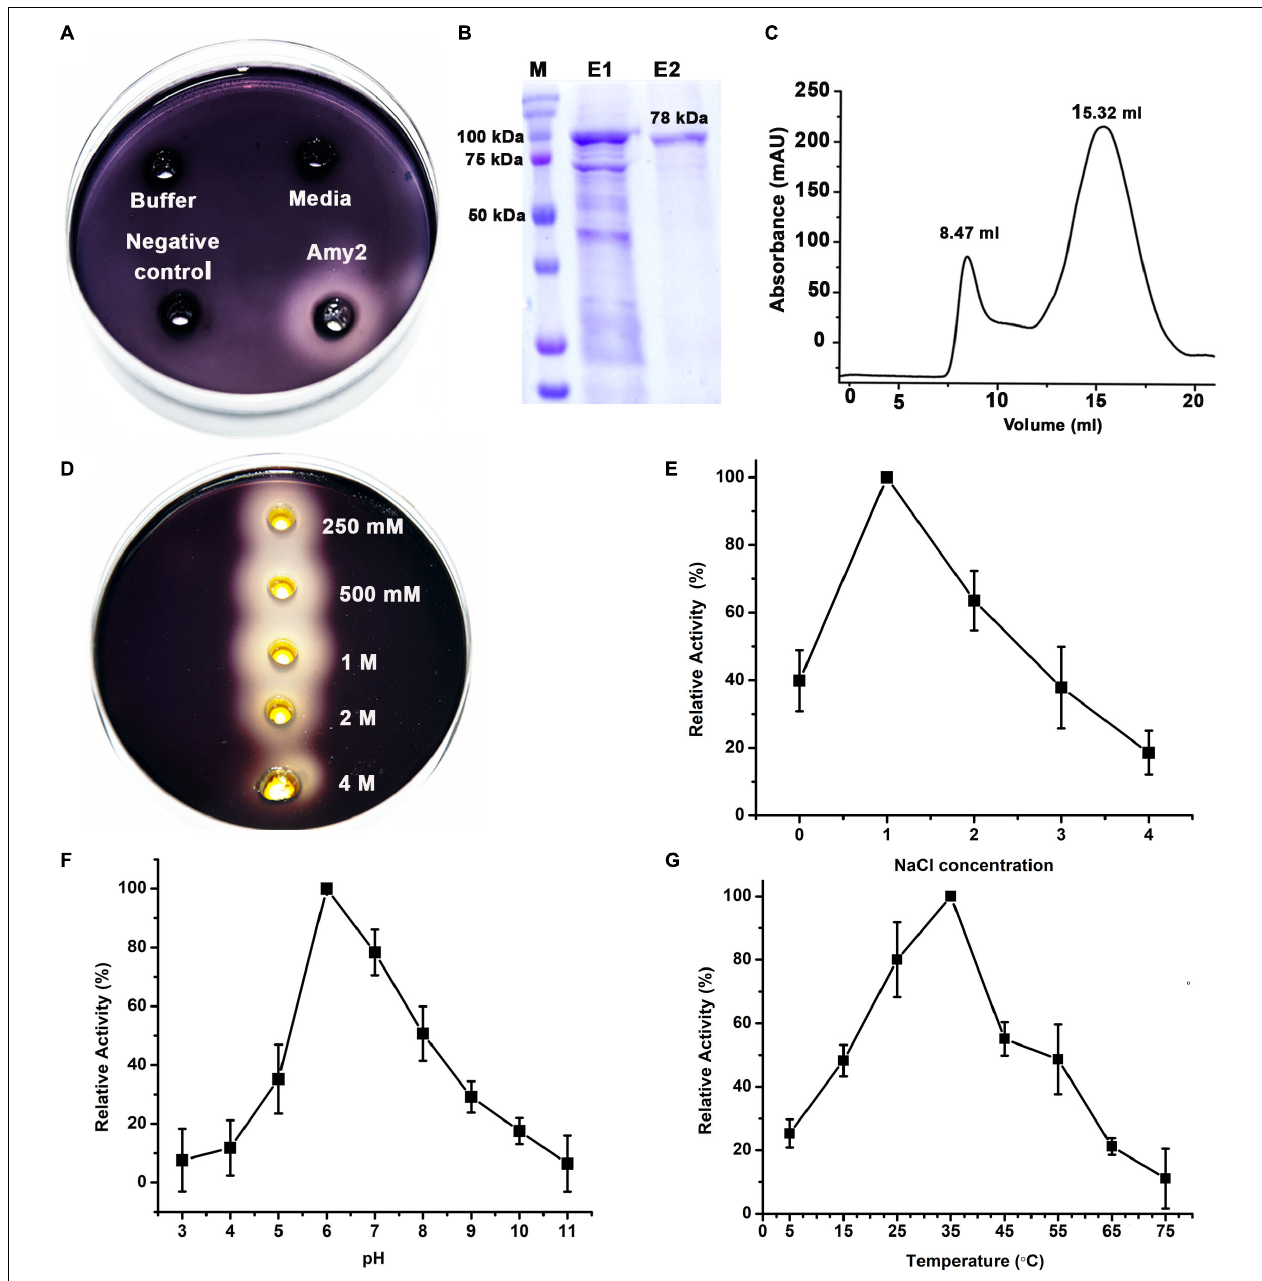
FIGURE 4 | The purification of recombinant α -amylase from E. coli , and carotenoids from wild type cultures. (A) The α -amylase activity observed from the cell-free supernatant of E. coli expressing recombinant Amy2. (B) The 15 % SDS-PAGE showing a predominant protein band at the expected molecular weight of ∼ 78 kDa in the gradient of imidazole elution fractions (E1, E2, E3 correspond to 20, 100, and 200 mM imidazole, respectively). (C) The analytical gel filtration profile suggests that Amy2 is predominantly monomeric in solution. A small fraction, corresponding to large aggregates, was also observed in the void volume (8.47 ml). (D) Evaluating salt tolerance of Amy2 using starch plate assay suggests that the enzyme is halotolerant. (E) The enzymatic activity of Amy2 against soluble starch was assayed by the iodine-starch method at the various concentrations of NaCl. Relative activity was defined as the percentage of maximum activity at 1 M NaCl. Plots showing effect of pH (F) and temperature (G) on the Activity of Amy2 and the relative activity was defined as the percentage of maximum activity observed at pH 6.0 or 35 ◦ C, respectively. All activity assays were performed three times in triplicate and mean value with standard deviation are plotted.